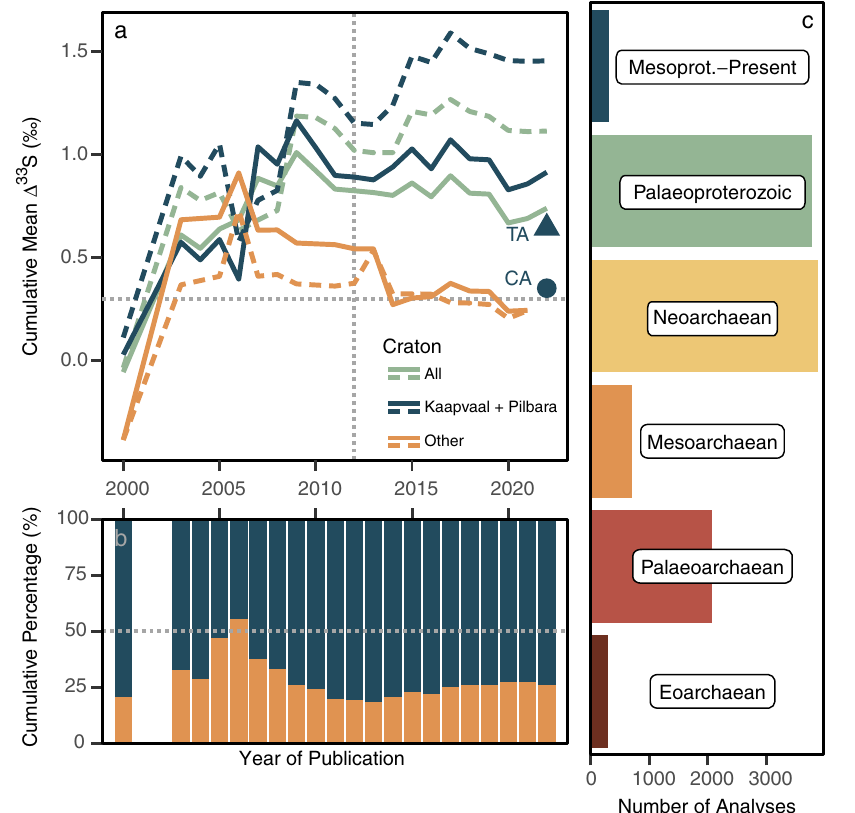
Fig. 2 | Spatial and temporal biases within the Δ 33 S record. a A cumulative plot depicting the evolving mean Δ 33 S value of the pre-2.3 Ga data in the com- piled multiple sulfur isotope (MSI) database, with solid and dashed lines repre- senting those derived from the full database and its spot sample averaged (SSA) counterpart, respectively ( “ Methods ” ). Line colour distinguishes the craton(s) being analysed, with green signalling the full database, blue illustrating the com- bined Kaapvaal – Pilbara datasets, and orange showing the remainder. For refer- ence, the respective mean Δ 33 S values of the Time Adjusted (TA) and Craton Adjusted(CA)syntheticdatasetsareplotted asablue-colouredcircleand triangle.